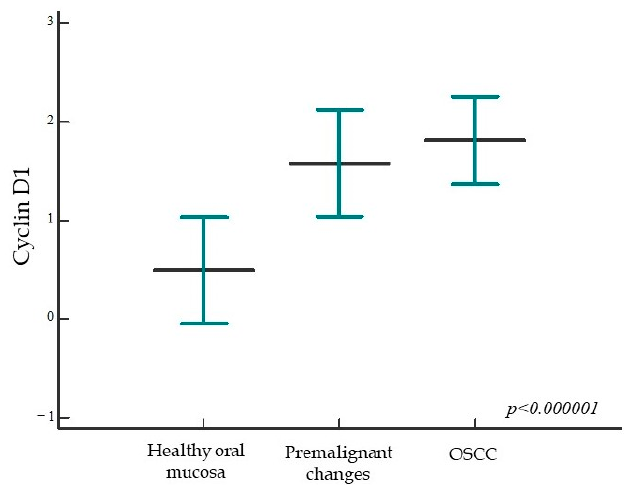
Figure 5. Cyclin D1 protein expression in the studied groups. The percentage of cyclin D1 protein expression is significantly higher in the group of patients with premalignant changes and OSCC compared with subjects with healthy oral mucosa; moreover, a statistically significant difference was found between all studied groups ( p < 0.000001). Horizontal lines show mean ± standard deviation; p , significance level is marked on Kruskal–Wallis graph.